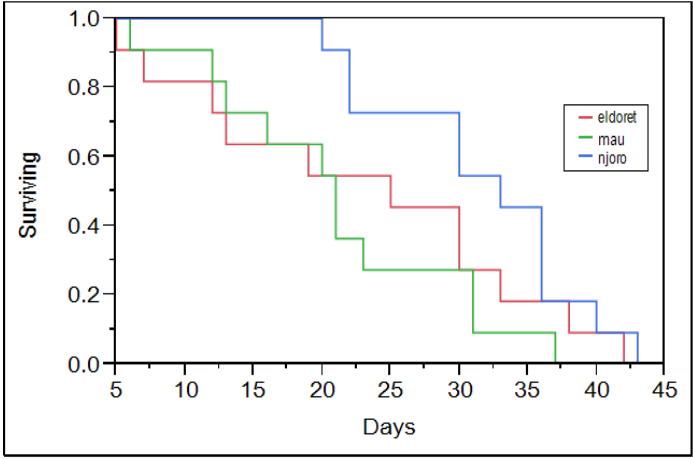
Figure 2. Survivorship curves for Eldoret and Mau Narok and Njoro RWA populations on Kwale. Table 2. Tests between groups on different host genotypes.